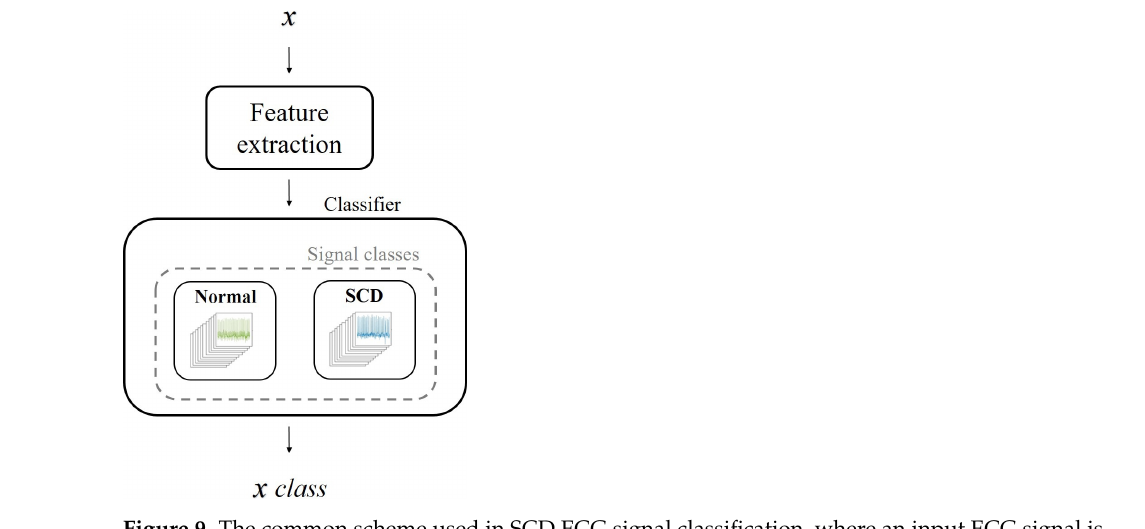
Figure 9. The common scheme used in SCD ECG signal classification, where an input ECG signal is identified as normal or SCD depending on its features; if a signal does not fit the characteristics of one class, then it is assumed to belong to the other. Table 2. Results of an individual test under the common schemme.